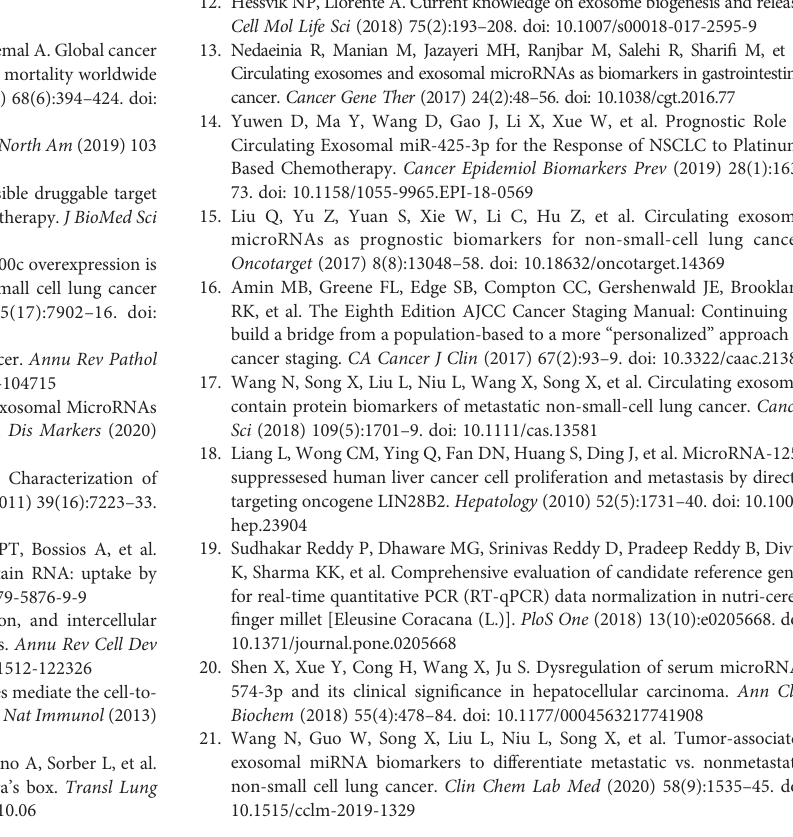
SUPPLEMENTARY FIGURE 1 | The expression levels of serum exosomal miRNAs in NSCLC patients and healthy donors. (A) miR-17-5p, (B) miR-9-5p, (C) miR-148-3p, and (D)